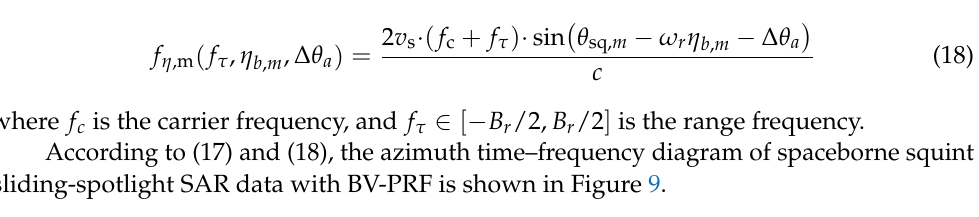
P R F m Figure 9. Azimuth time – frequency diagram of squint sliding-spotlight SAR data with BV-PRF. The total Doppler bandwidth of the squint sliding-spotlight SAR data with BV-PRF can be computed as